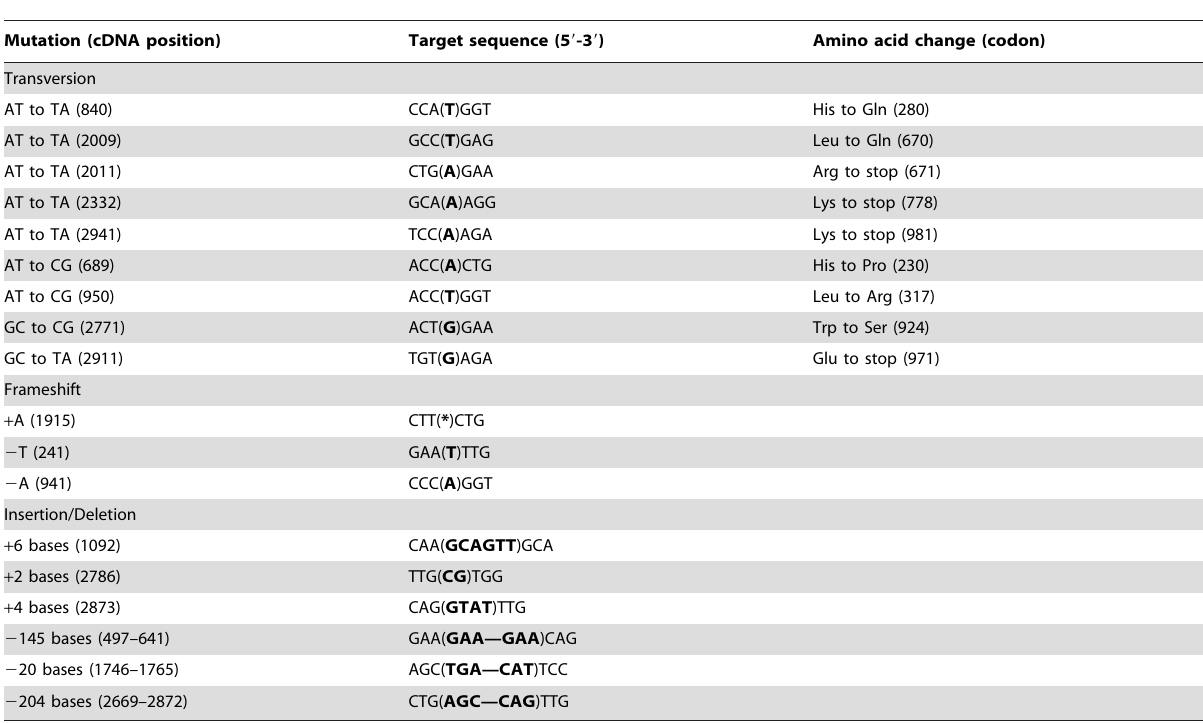
Table 2. Mutational spectrum of PIG-O gene in DT40 cells exposed to MMS at 100 m